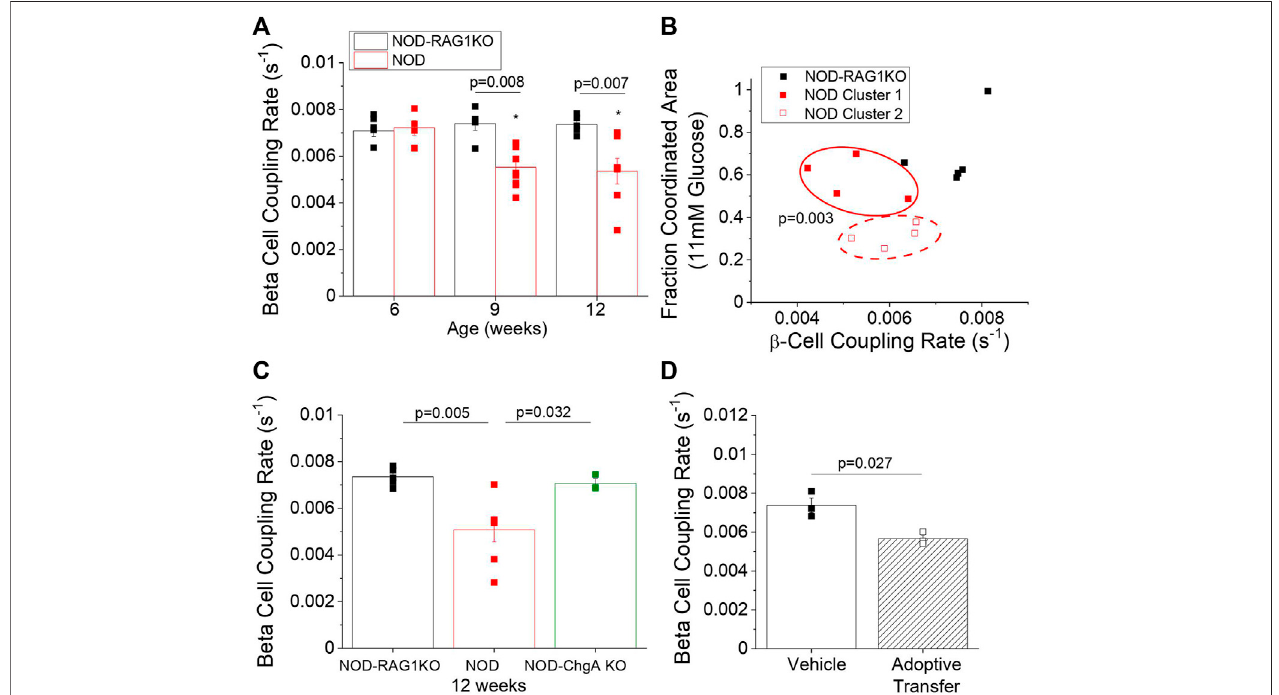
FIGURE 3 | NOD mice have decreased β -cell coupling as early as 9 weeks of age and decreased β -cell coupling in the NOD mouse is mediated by autoreactive T-cells. (A) β -cellcouplingasmeasuredby fl uorescencerecoveryrateinisolatedisletsfrom6,9,and12-weekoldNOD(red, n =6 – 9)andNOD-RAG1KO(black, n =5 – 6) mice.Datarepresentthemean±SEM.Datafrom individualmice arerepresented byblackand redsquaresfor NOD-RAG1KO andNOD micerespectively( n =3 – 6). p < 0.05 is signi fi cant as determined by ANOVA. (B) K-means clustering analysis of the correlation between β -cell coupling and the fraction of the islet area with coordinated intracellular Ca 2+ oscillations at 11 mM glucose in NOD and NOD-RAG1KO mice at 9 weeks of age. Red solid and dashed ovals indicate the clusters of animals identi fi ed by k-means analysis. (C) β -cell coupling as measured by fl uorescence intensity recovery rate in isolated islets from 12-week old NOD (red), NOD- RAG1KO (black), and NOD chromogranin-A knockout (NOD-ChgA KO, green). Data from individual mice are represented by black, red, or green squares for NOD- RAG1KO, NOD, or NOD-ChgA KO mice respectively ( n = 4 – 5). (D) β -cell coupling as measured by fl uorescence intensity recovery rate in isolated islets from mice 2 weeks post-adoptive transfer with diabetogenic splenocytes or vehicle control. Data from individual mice are represented by solid or open squares for vehicle or adoptivetransfermicerespectively( n =3).DatainAandBrepresentthemean±SEM. p < 0.05issigni fi cantasdeterminedbyANOVAinAandt-testinB.Allanimalsare female unless otherwise